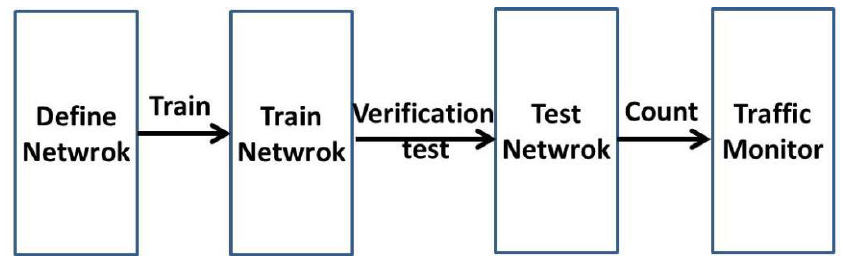
Figure 1. You Only Look Once (YOLO) monitoring architecture.